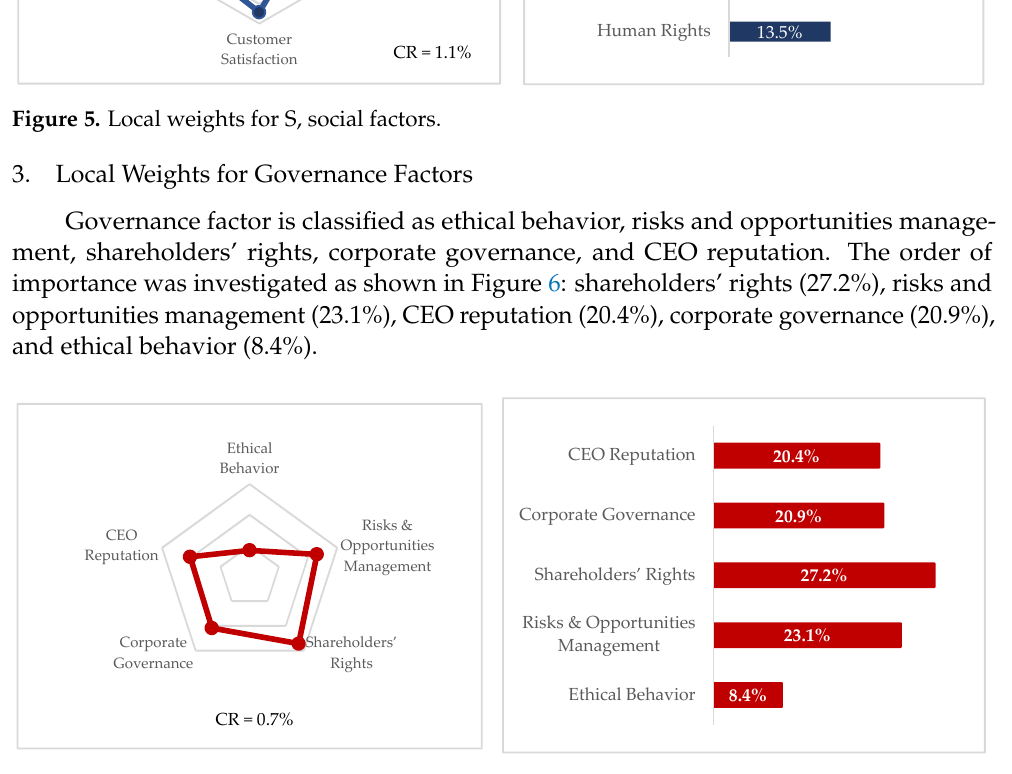
Figure 6. Local weights for G, governance factors.